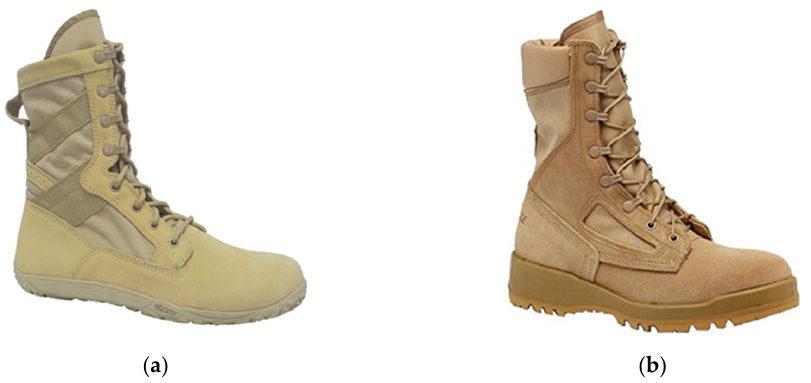
Figure 1. Two types of footwear used in the study. ( a ) Belleville TR101 MiniMil ultra-light minimalist tactical military boot (MIN); ( b ) Belleville 310ST hot weather standard tactical boot (STD). Table 1. Design characteristics of the two types of military footwear used in the study. Design